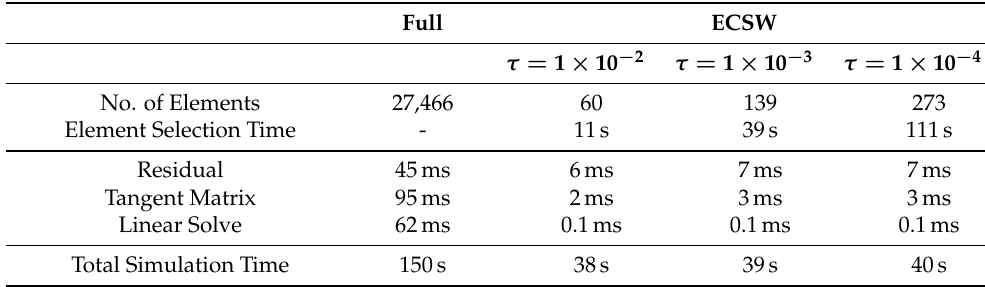
Table 3. Computational times of different simulation steps for the three reduced-order models compared with the full training